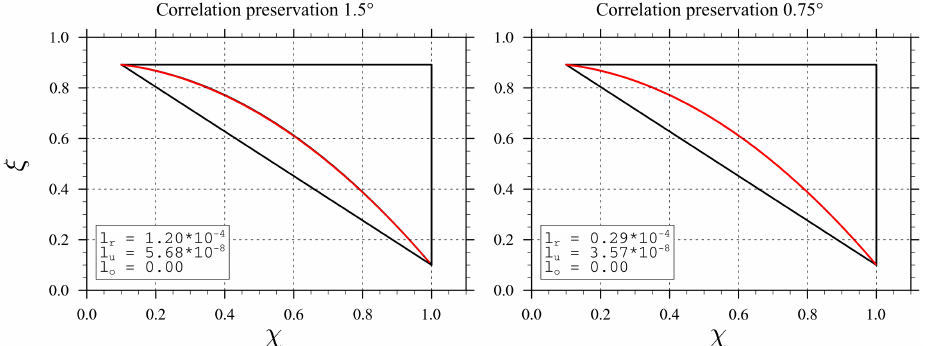
Figure 11. Diagnostics for correlation preservation for the model grid resolution 1.5 and 0 . 75 ◦